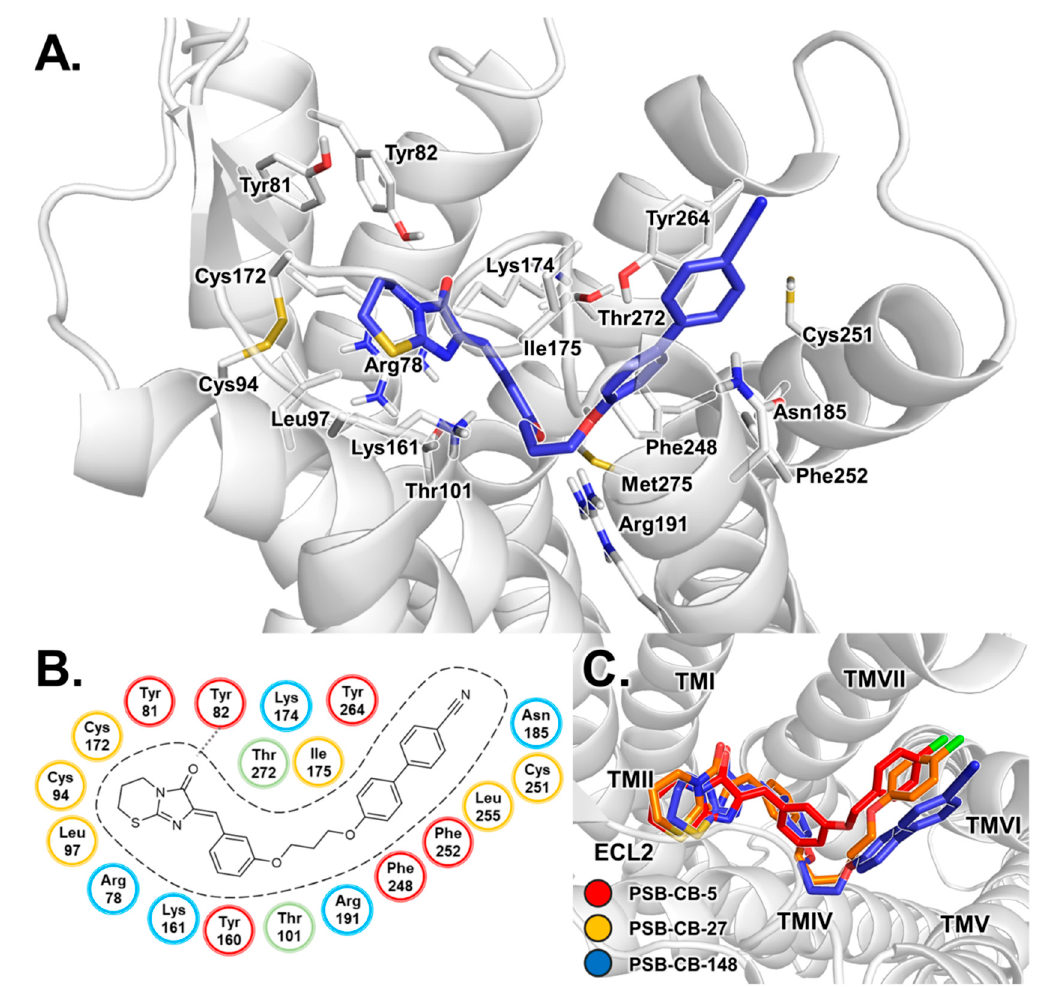
Figure 6. Proposed binding mode of antagonist 6 . ( A ) Docked pose of 6 in complex with the homology model of human GPR18 shown with the residues forming the binding pocket. ( B ) Schematic 2D representation of the binding pocket. For color code, see Figure 2. ( C ) Overlay of the proposed binding modes of GPR18 antagonists. Antagonist 4 is colored in orange, antagonist 5 in red, antagonist 6 in blue.